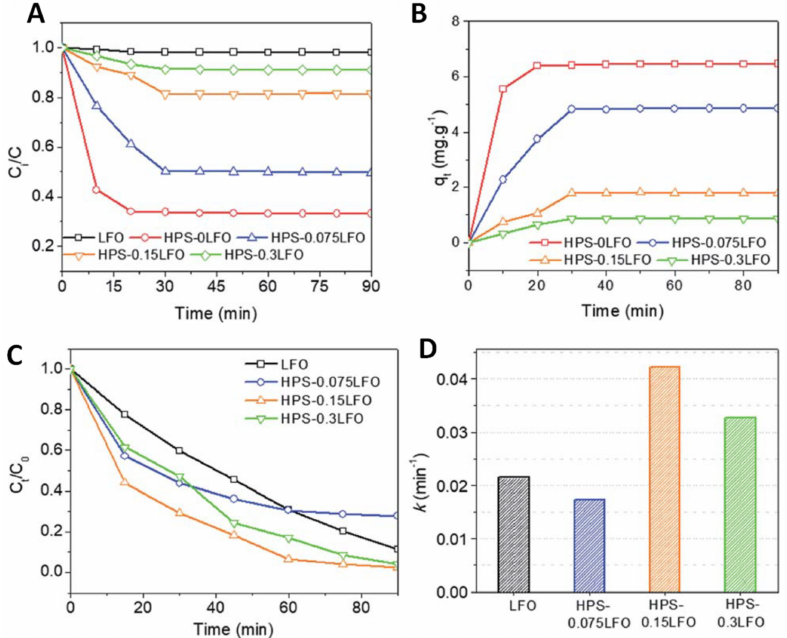
Figure 4. ( A ) Removal of RhB via adsorption by using LFO or HPS_xLFO. ( B ) The corresponding RhB adsorption capacity. ( C ) Removal of RhB in the photo-Fenton reaction using LFO or HPS-xLFO (x = 0.075, 0.15, and 0.3) and ( D ) corresponding degradation rate constants. Operating conditions: T = 25 ◦ C, initial dye concentration = 10 mg/L, catalyst dosage = 1 g/L, initial H 2 O 2 concentration = 10 mM and pH 0 = 6). Reproduced with permission from Ref. [87]. Copyright of Royal Society of